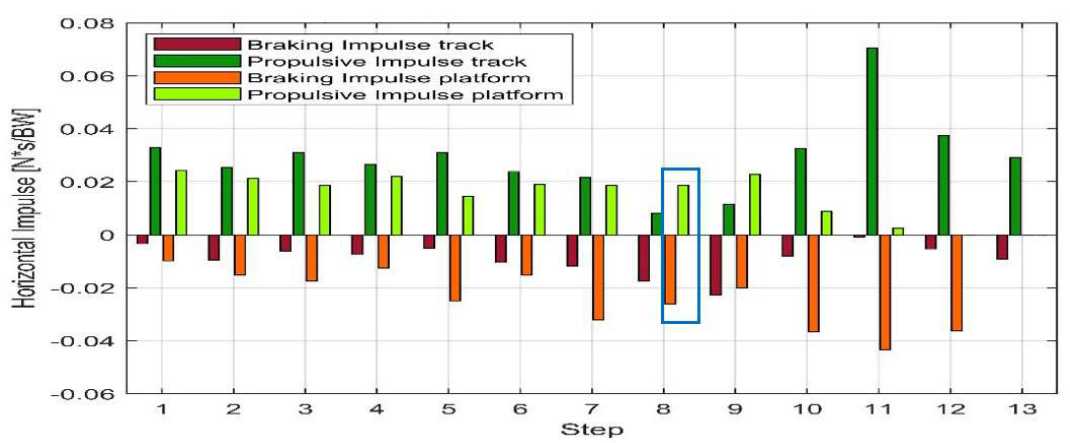
Figure 15. Comparison of the horizontal impulse from the affected limb calculated with the iRPF between the sprint aiming to the force platform and a free sprint on track: all steps of the test aiming to a force platform (Run 10 “platform”) in light colors (platform is on Step 8) and all steps of a free sprint test on track without platform (Run 12, “track”) in dark colors.